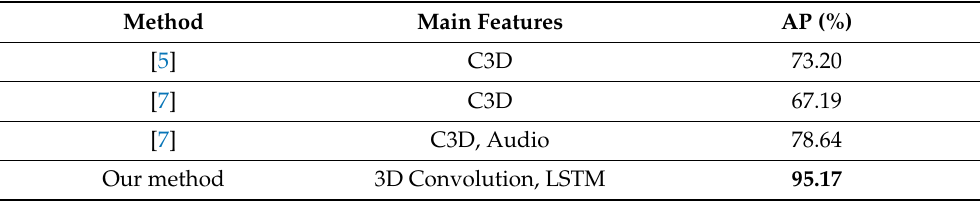
Table 2. A comparison between the performances of the proposed framework and other state-of-the- art methods on the XD-Violence dataset (best value found in